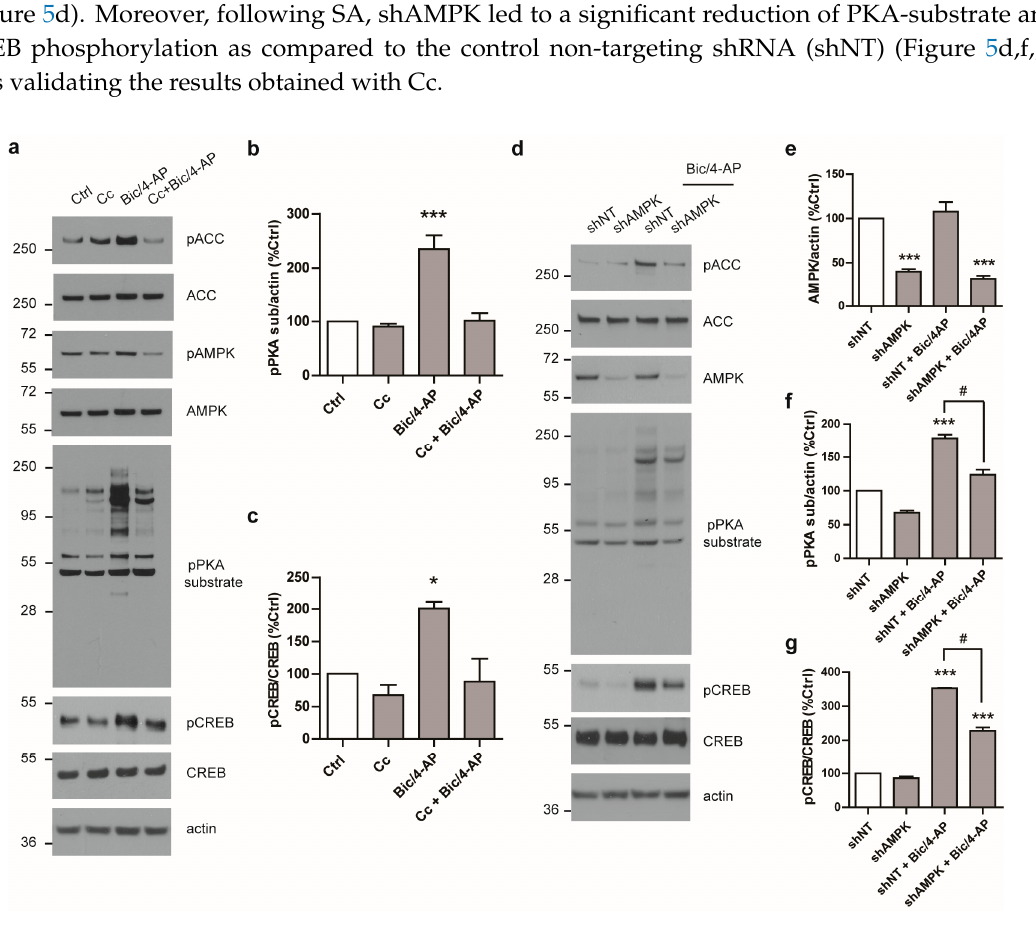
Figure 5. AMPK regulates PKA activation following SA. ( a ) Primary neurons at 15 DIV treated with Bic/4-AP (50µM/2.5mM, 10 min) with or without 20 min pre-treatment with the AMPK inhibitor Compound C (Cc, 10 µM) were subjected to immunoblotting with anti- phospho-AMPK (pAMPK), phospho-ACC (pACC), phospho-PKA substrate (pPKA sub), phospho-CREB (pCREB), total AMPK, ACC, CREB, and actin antibodies. ( b , c ) Quantification of WB as in (a) showing the ratios pPKA sub/actin ( b ) and pCREB/CREB ( c ) expressed as a percentage of control ( n = 6). ( d ) 15 DIV primary neurons transduced for seven days with control non-targeting short hairpin RNA (shRNA) non-targeting shRNA (shNT) or with AMPK shRNA (shAMPK) were stimulated with Bic/4-AP (10 min) and subjected to immunoblotting with anti- pACC, pPKA sub, pCREB,total AMPK, ACC, CREB, and actin antibodies. ( e , f , g ) Quantification of WB as in (d) showing the ratios AMPK/actin ( e ), pPKA sub/actin ( f ), and pCREB/CREB ( g ) expressed as percentage of control ( n = 3). Results show mean ± SD. One-way ANOVA followed by Bonferroni’s post-hoc test were used for evaluation of statistical significance. * p < 0.05, ** p < 0.01, *** p < 0.001 as compared to Ctrl ( b , c ) or shNT ( e , f , g ), # p < 0.05 as compared to shNT + Bic/4-AP condition ( e , f ).